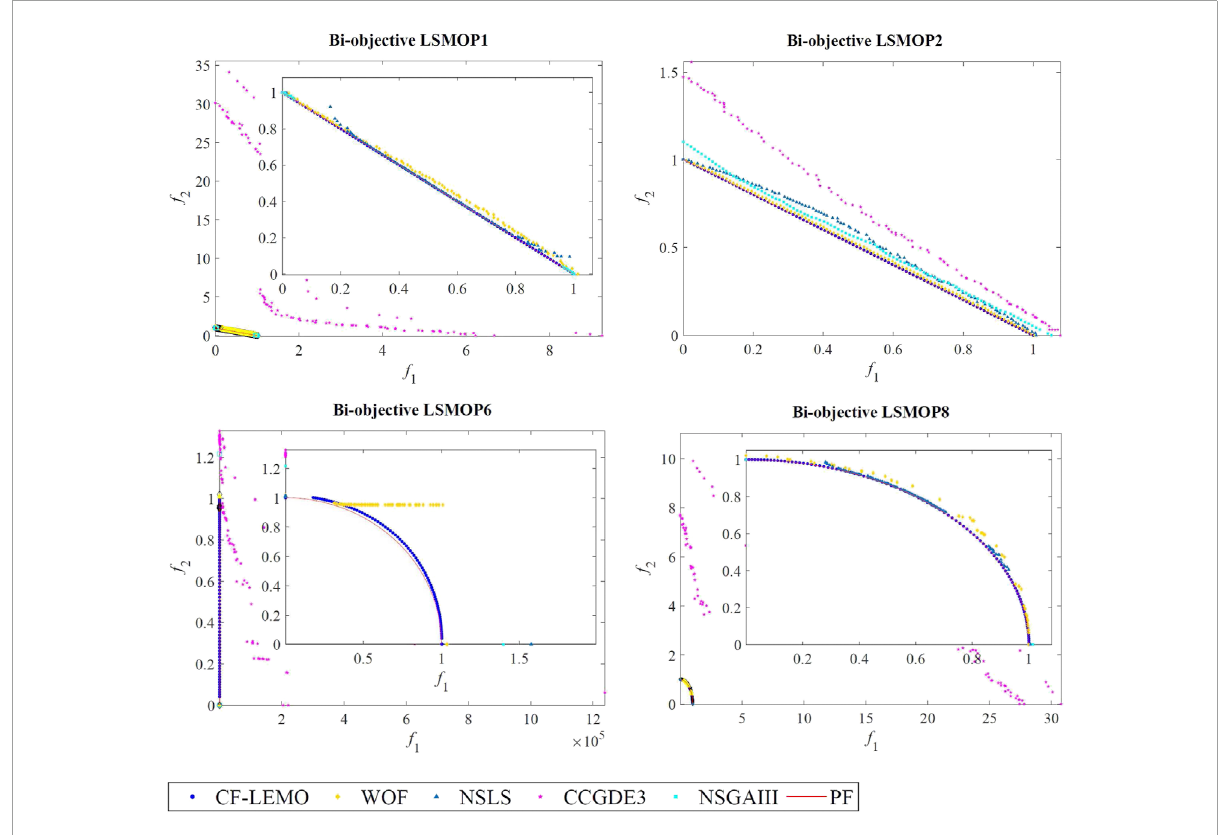
FIGURE 2 Output populations of CF-LEMO, WOF, NSLS, CCGDE3, and NSGA-III on bi-objective LSMOP1, LSMOP2, LSMOP6, and